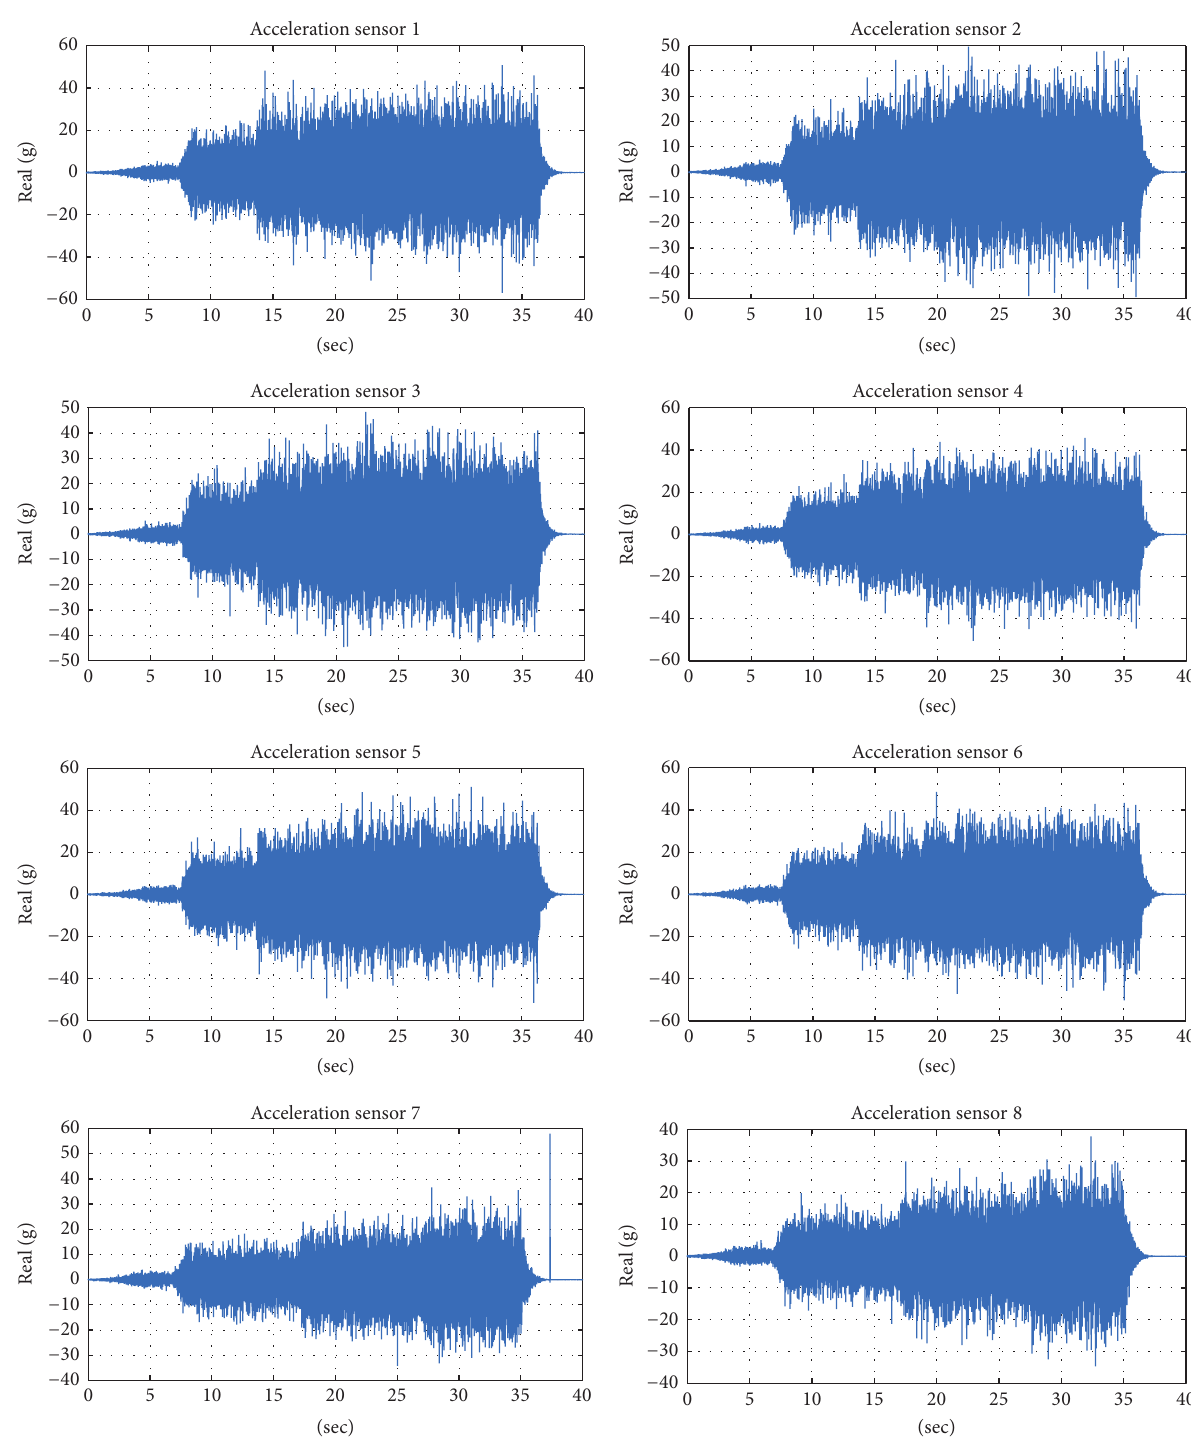
Figure 5: Time-domain dynamic response of measurement points 1 to